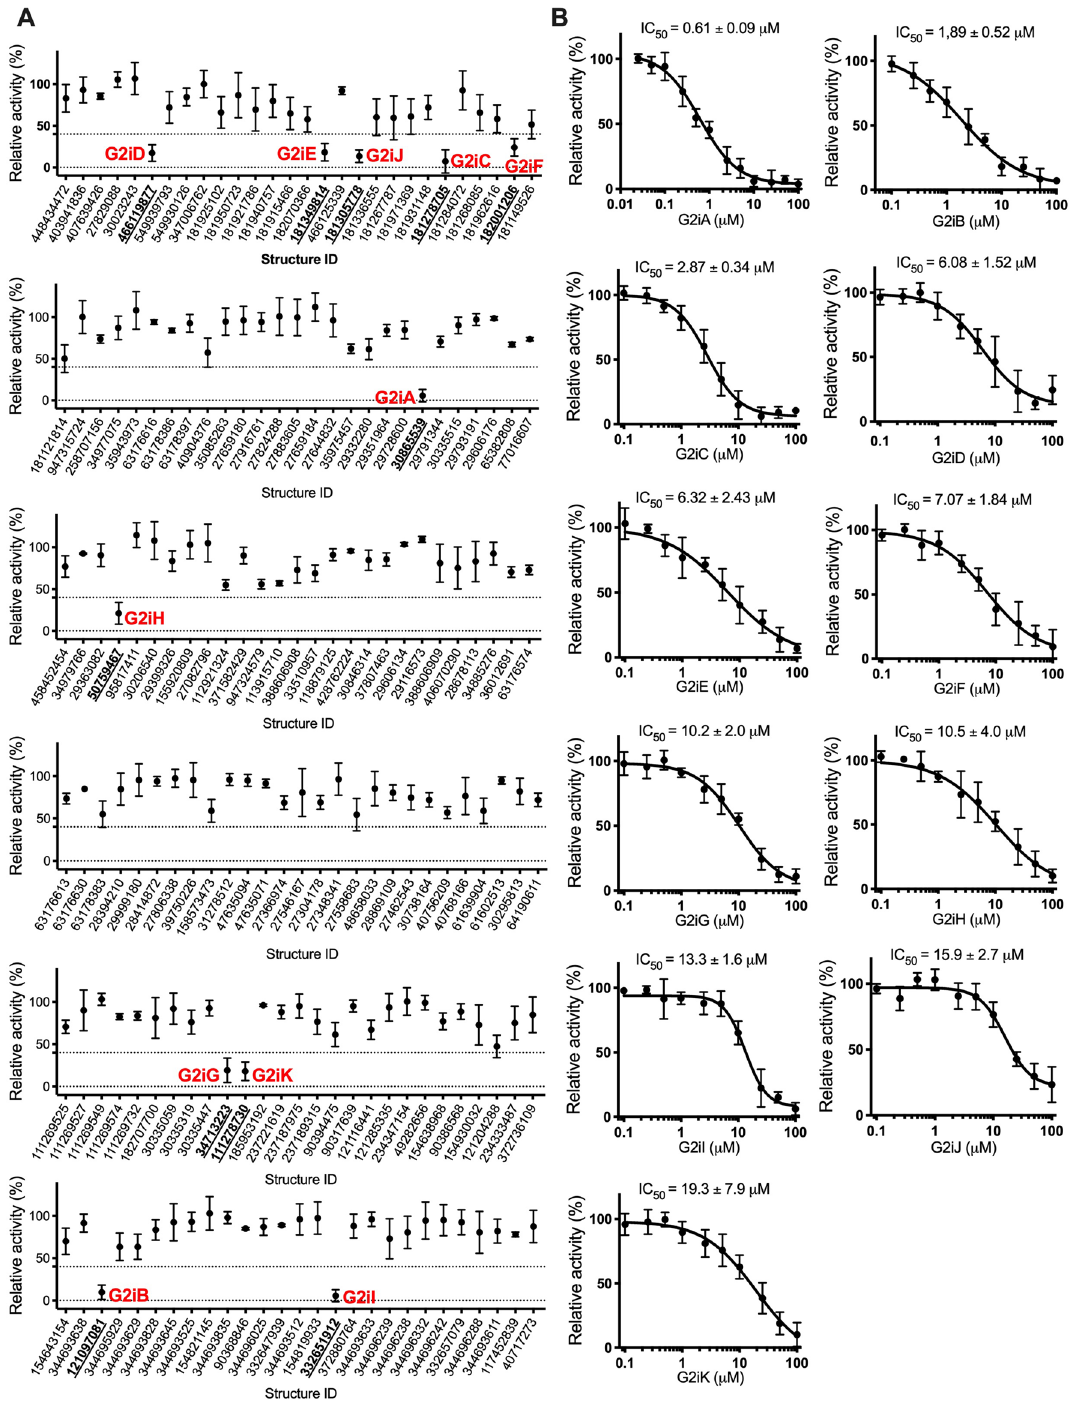
Figure 2. Effect of compounds identified from in silico ligand screening on GLUT2 transport activity. ( A ) GLUT2 relative transport activity at 15 mM glucose concentration, in the presence of 100 µM compound concentration (see “Materials and methods” for details). The compounds (see also Supplementary Table S1) are identified by the ChemNavigator structure ID. Eleven compounds (designated as G2iA-K, in red, with the corresponding structure ID in bold, underlined font) inhibited GLUT2 relative activity by more than 60% (marked by the dotted line). ( B ) Dose–response curves for G2iA-G2iK (see also Table 1) inhibition of GLUT2 transport activity. Standard deviations for experimental points, represented by error bars, come from at least three independent